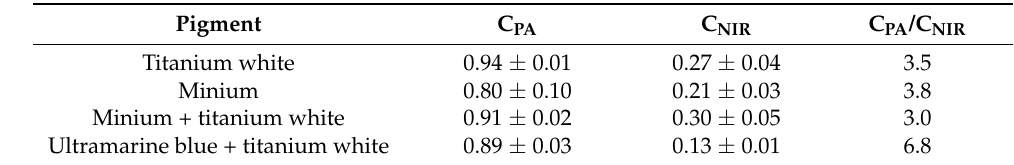
Table 1. Contrast quantification for PA (C PA ) and NIR optical images (C NIR ) of mock-ups covered by different pigmented layers (thickness 250 µ m). Uncertainties correspond to the standard error of each mean out of five